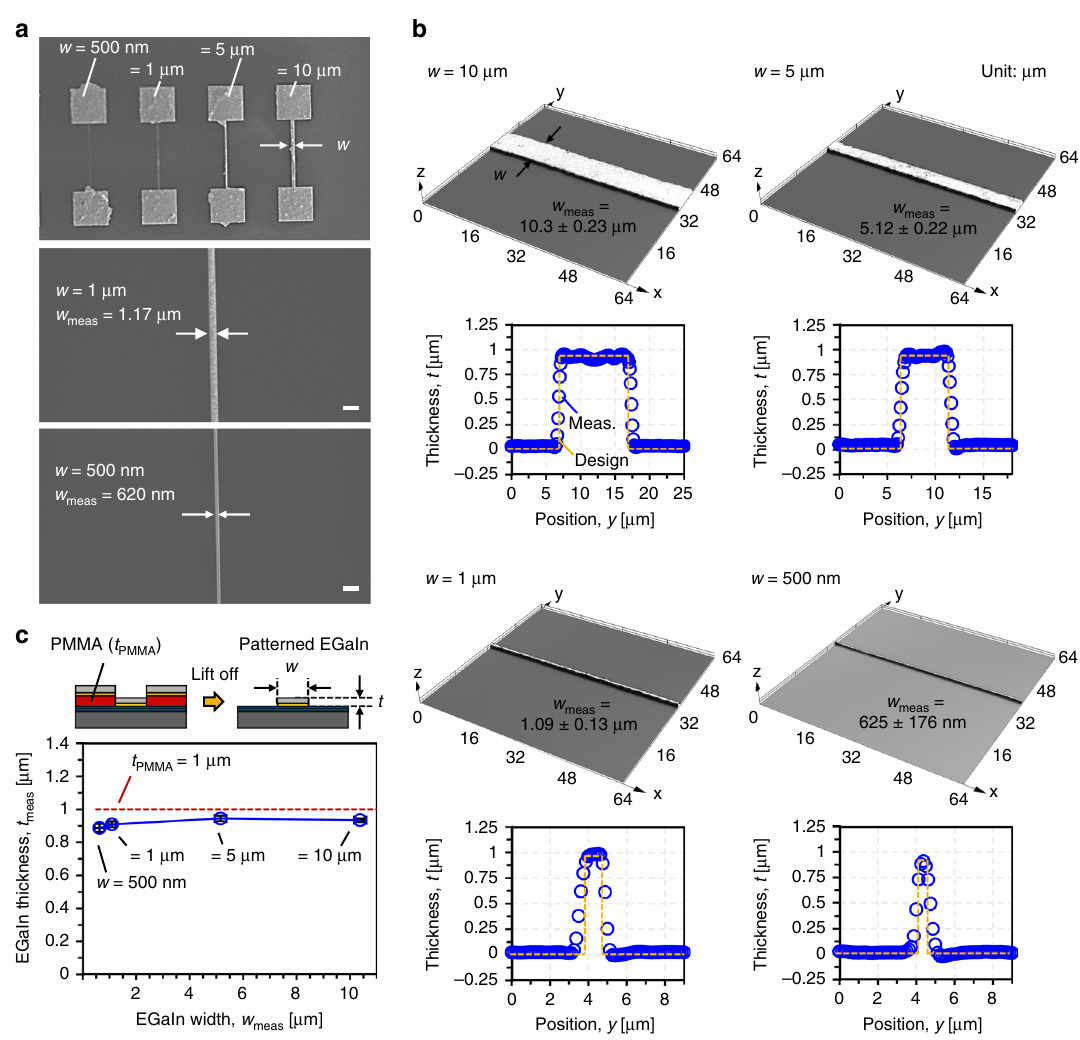
Fig. 2 Patterned EGaIn nano/microstructures. a SEM images of EGaIn lines with widths from 10 µ m to 500 nm and close-up of EGaIn lines with 1 µ m and 500 nm width. Scale bars indicate 2 μ m. b 3D images and cross-sections of EGaIn lines with width of 10 µ m, 5 µ m, 1 µ m, and 500 nm. The blue symbols represent the measured pro fi le, while the dashed yellow line indicates the designed cross-section. c Measured thickness of fabricated EGaIn lines as a function of line width. The x- and y-error bars represent the standard deviation. The thickness of the PMMA fi lm (1 µ m) is shown as dashed red line for